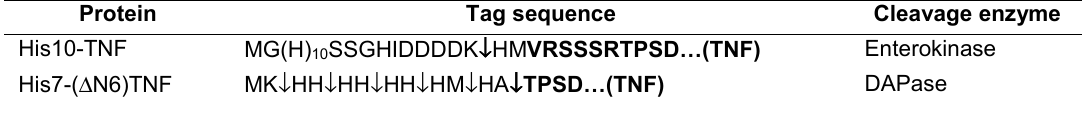
Composition of the N-Terminal Part of Model Proteins His10-TNF and His7-( ∆∆∆∆ N6)TNF